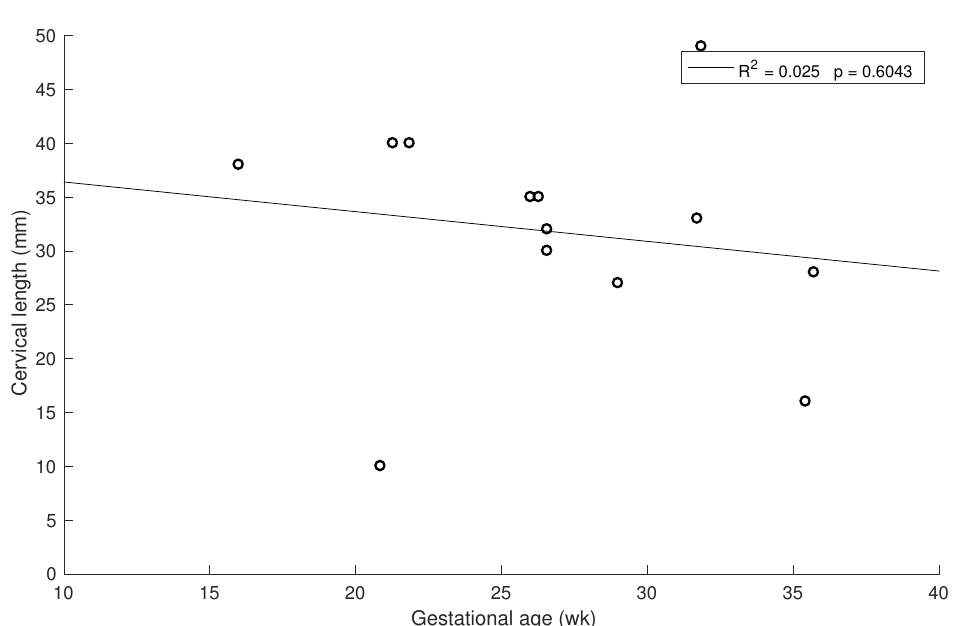
Figure 8. Relationship between cervical length and gestational age at time of examination.